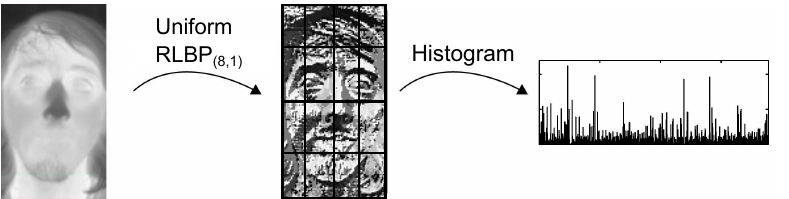
Figure 3. Ahonen’s algorithm using uniform